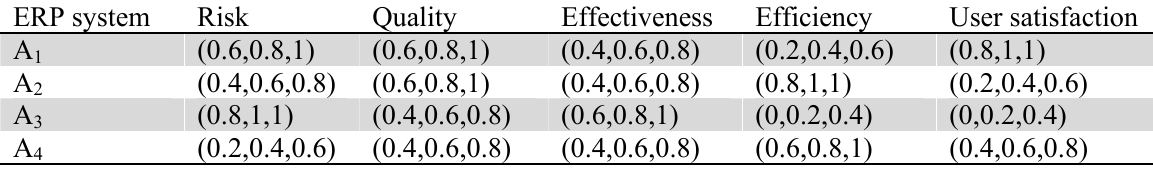
Fuzzy ERP system selection decision matrix for example 1